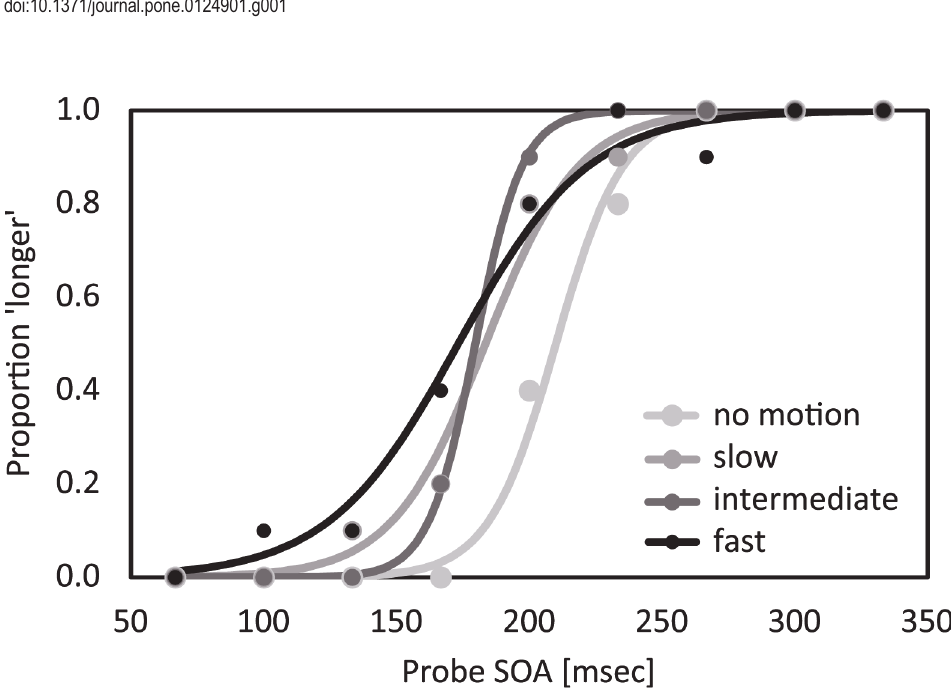
Fig 2. Psychometric functions for the four conditions obtained for participant T. Y. Filled circles and solid lines show the raw data and fitted psychometric curves, respectively.